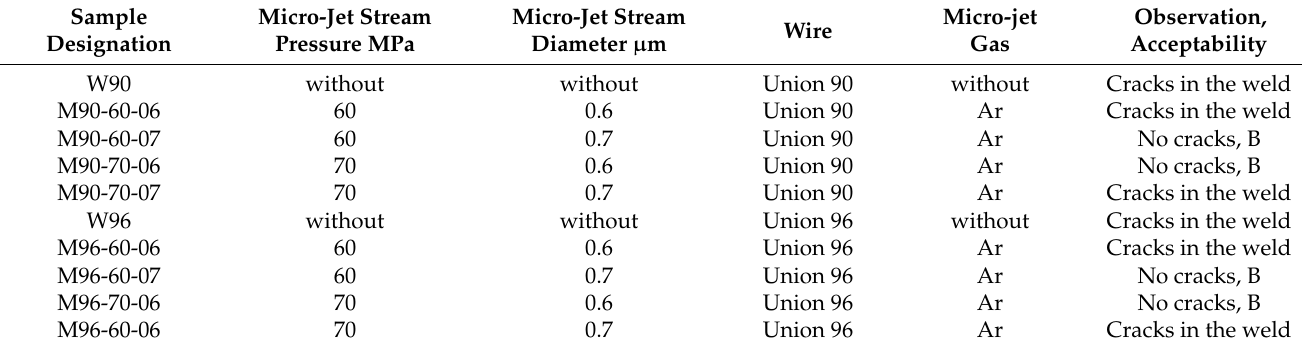
Table 2. Assessment of non-destructive testing of the movable platform joint.